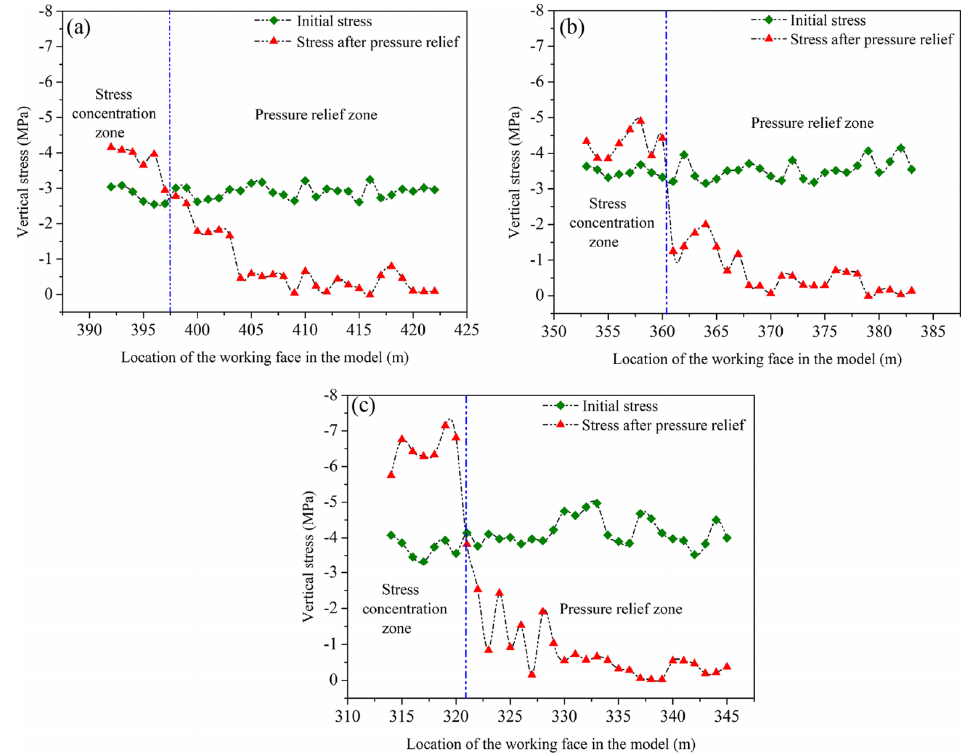
Figure 9. The change of the vertical stress in the coal 5 m below the goaf: ( a ) the 5th slice, ( b ) the 10th slice and ( c ) the 15th slice.